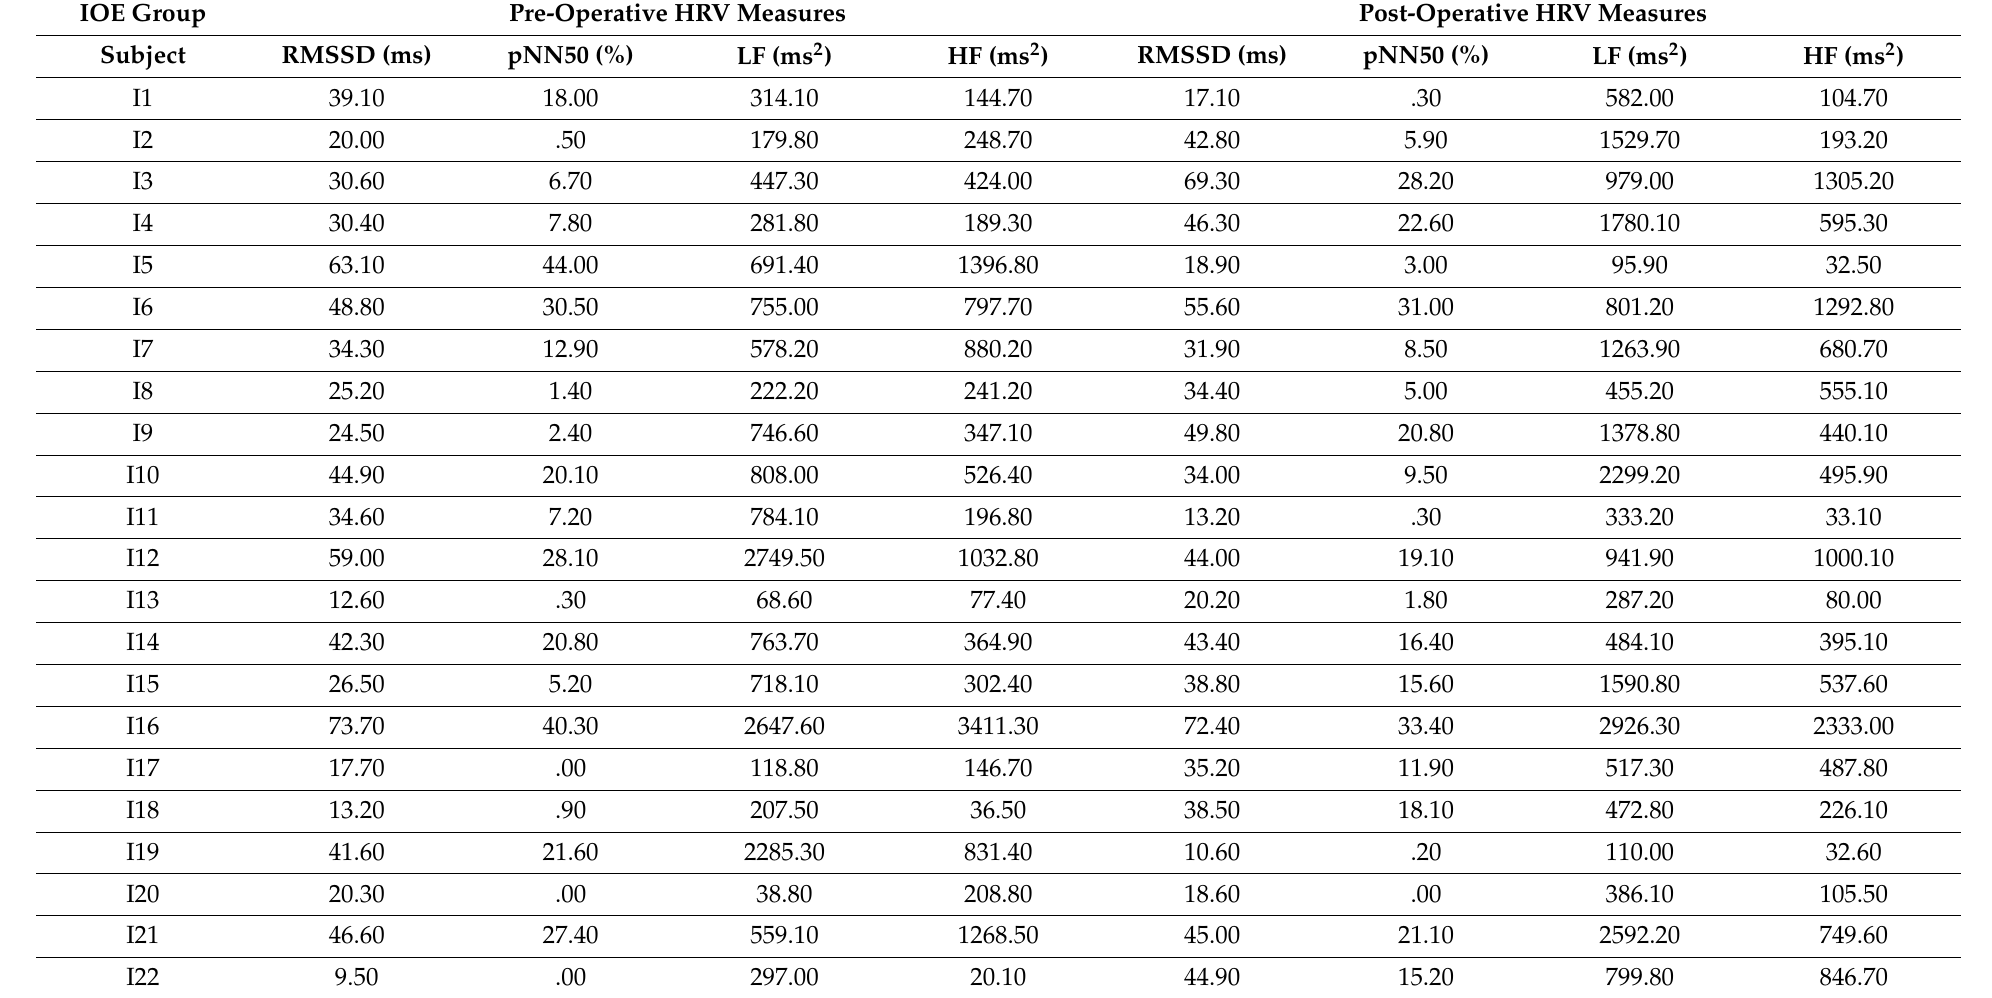
Table A3. HRV measures of each